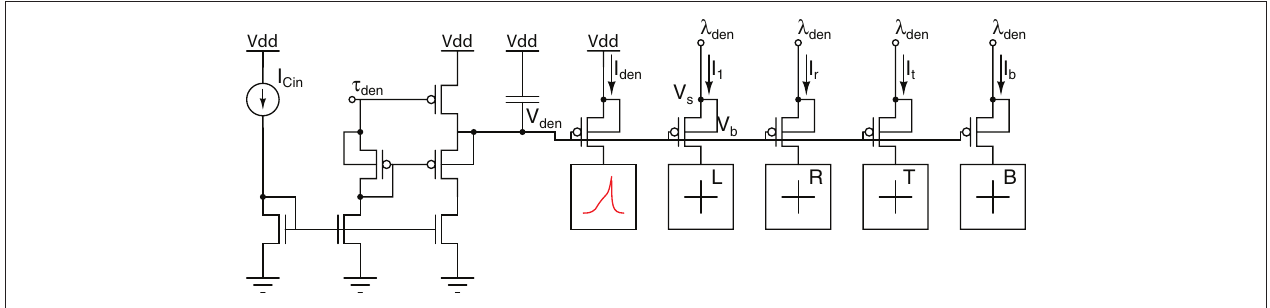
FIgure 6 | Dendritic membrane circuit and cable circuit connecting the compartments. The “ + ” blocks indicate neighboring compartments. The block to which I flows into is similar to the circuit in Figure 2a . den